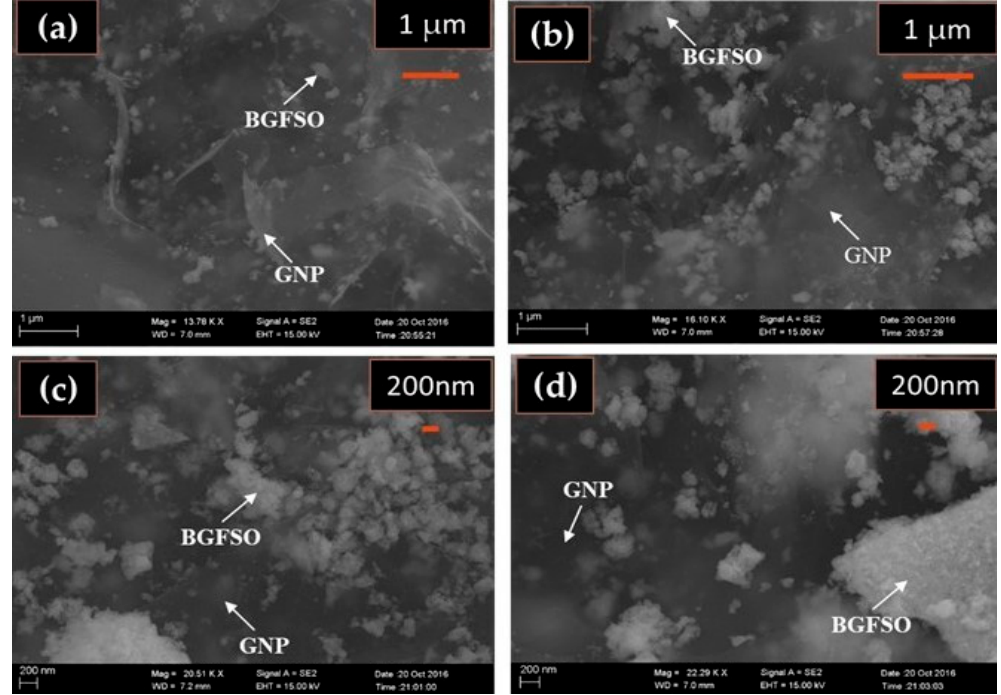
Figure 3. SEM patterns of BGFSO/GNP nanohybrids: ( a ) BGFSO-5/GNP; ( b ) BGFSO-15/GNP; ( c ) BGFSO-20/GNP; ( d ) BGFSO-25/GNP.